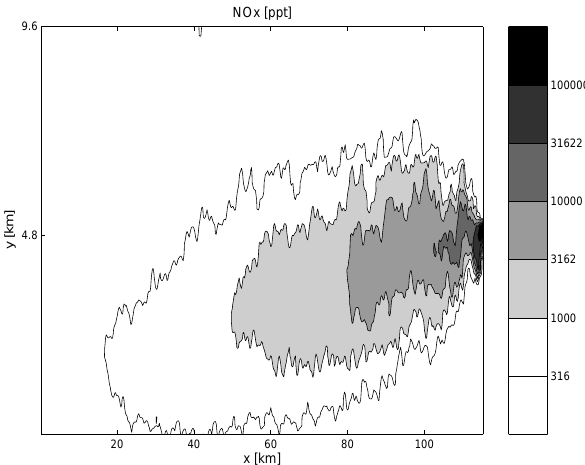
Fig. 1. Lowest vertical level of the NO x (NO+NO 2 ) plume in the highest resolution (C1) experiment at noon (local time) on day 2, af- ter the plume has evolved for 24h. Darker shading indicates higher NO x concentrations. Contour intervals are base 10 logarithmic in units of